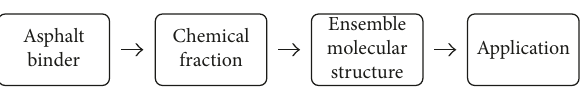
Figure 2: Schematic view of MD simulation in asphalt